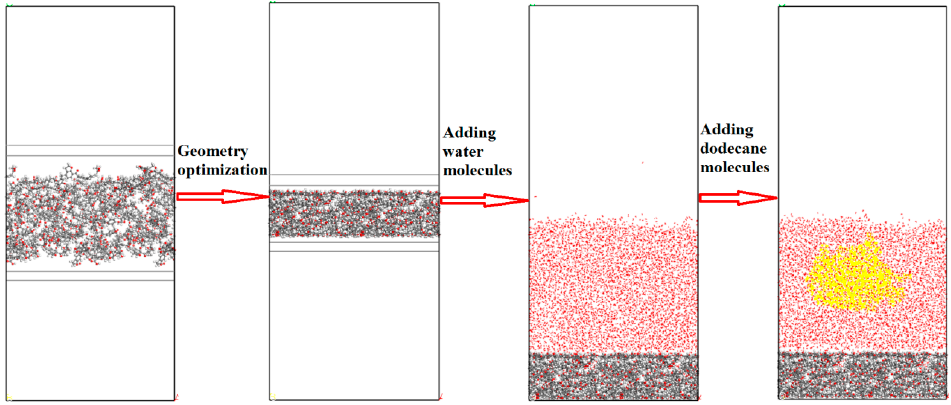
Figure 2. Coal-water-collector system construction process (the thicknesses of coal seam and water layer were 16.8 Å and 55